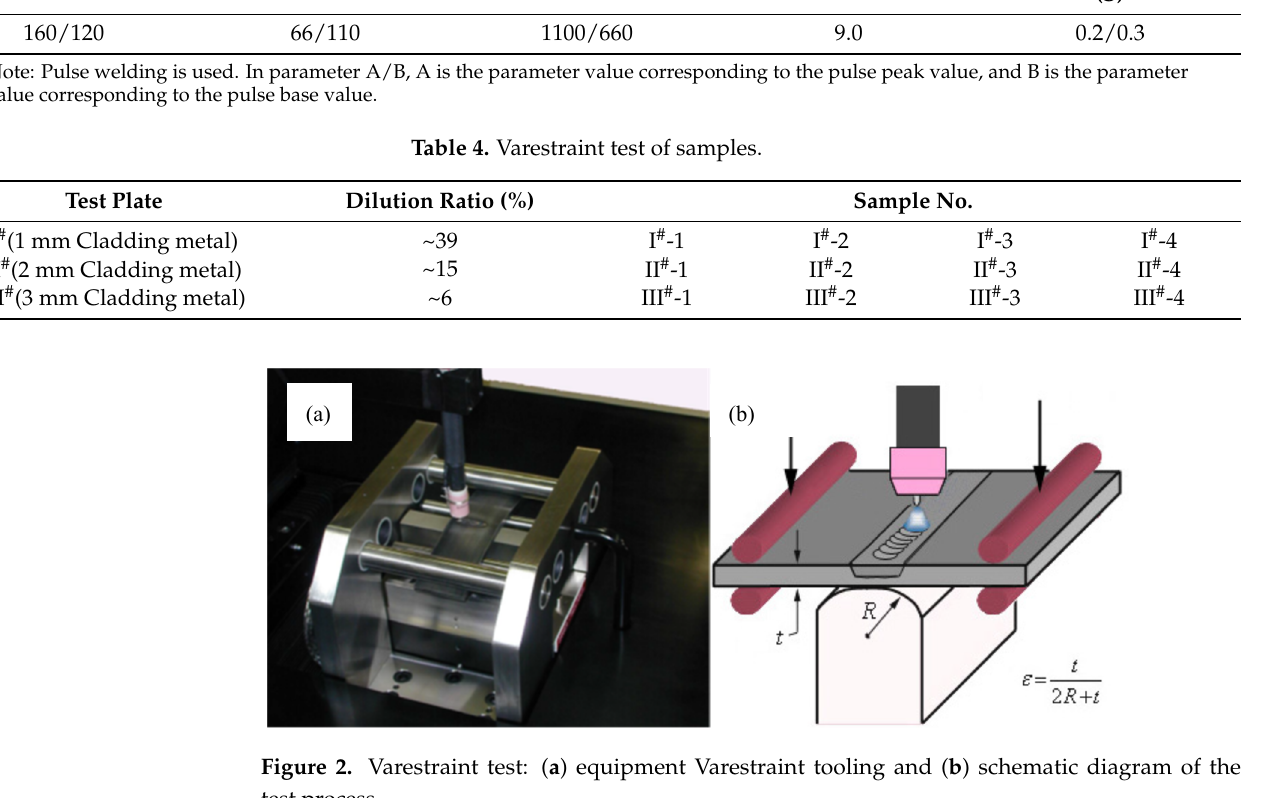
Table 3. Test board welding and filling parameters.